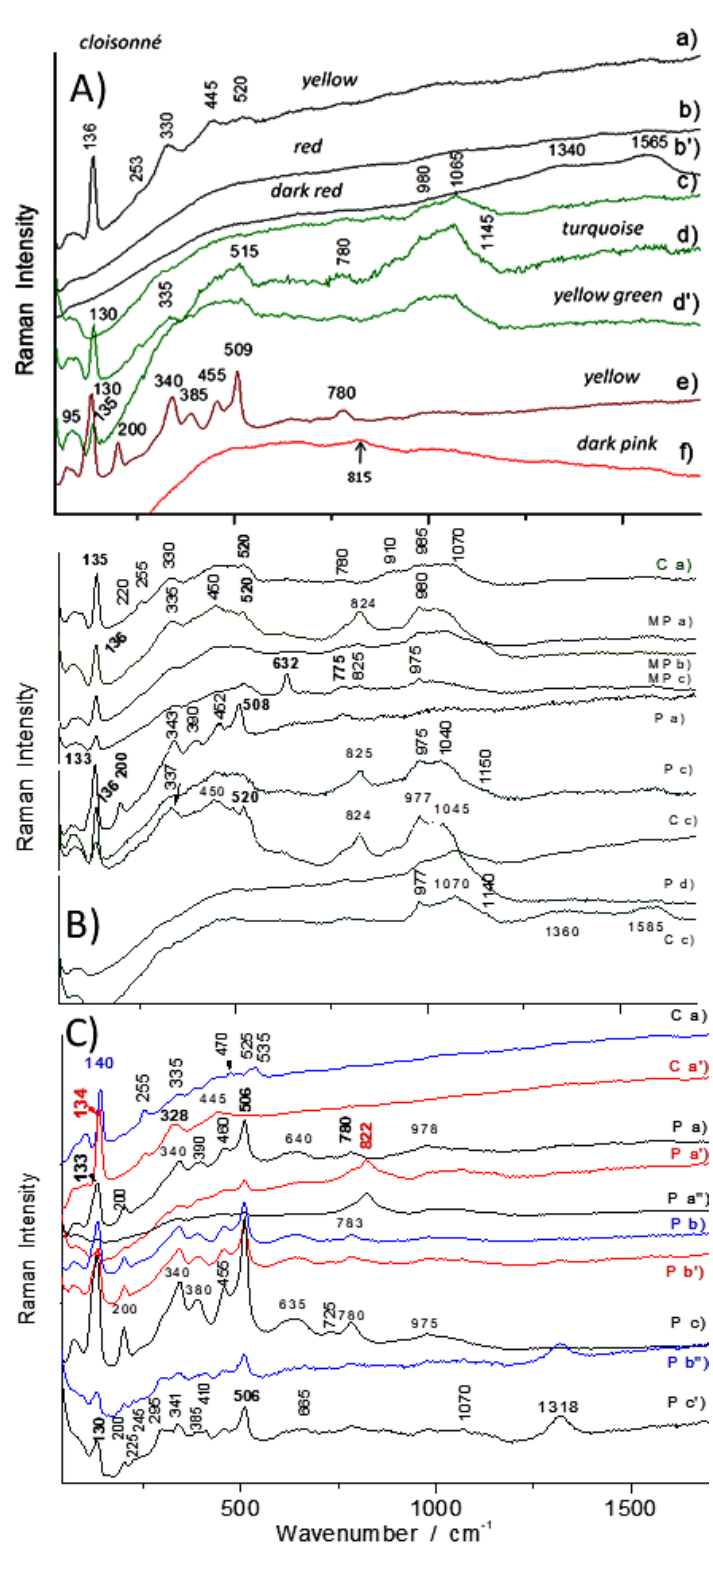
Figure 7. Representative Raman spectra recorded on the F1467.1 and F1467.2 ewers (Qianlong period): ( A ) cloisonné areas of different colours; ( B ) green cloisonné (spectra C) and painted (spectra P) areas (MP: painted areas of the medallion; two bottom spectra: turquoise areas); ( C ) yellow to orange cloisonn é (C) and painted (P)